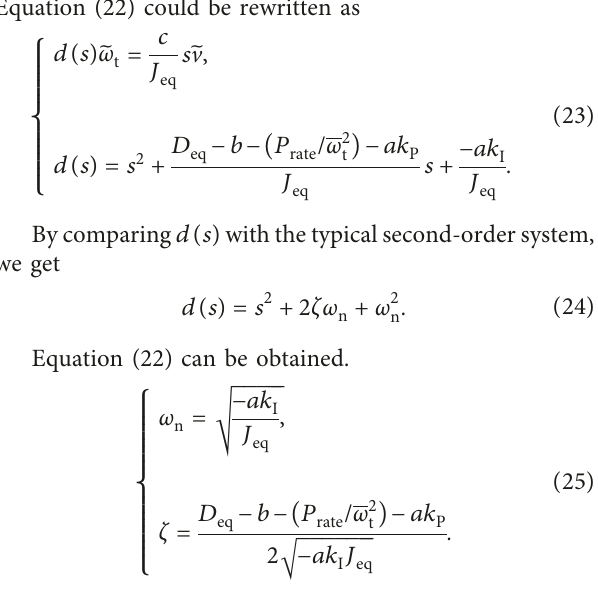
Figure 11: Torque characteristics of